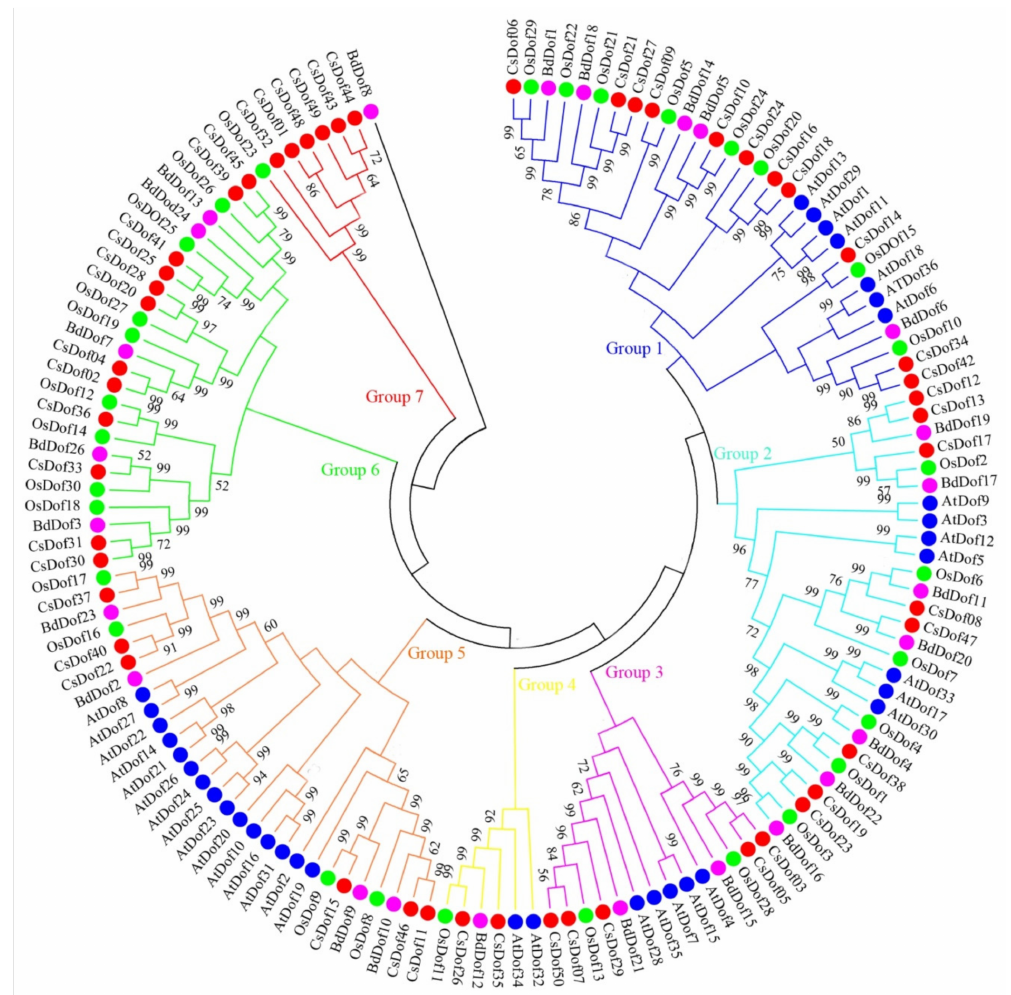
Figure 5. Phylogenetic tree representing relationships among Dof domains in C. songorica , A. thaliana , O. sativa , and B. distachyon . The different colors indicate different species: red represents Dof genes from C. songorica , blue represents Dof genes from Arabidopsis , green represents Dof genes from O. sativa and purple represents Dof genes from B. distachyon . Bootstrapping values are indicated as percentages (when >50%) along the